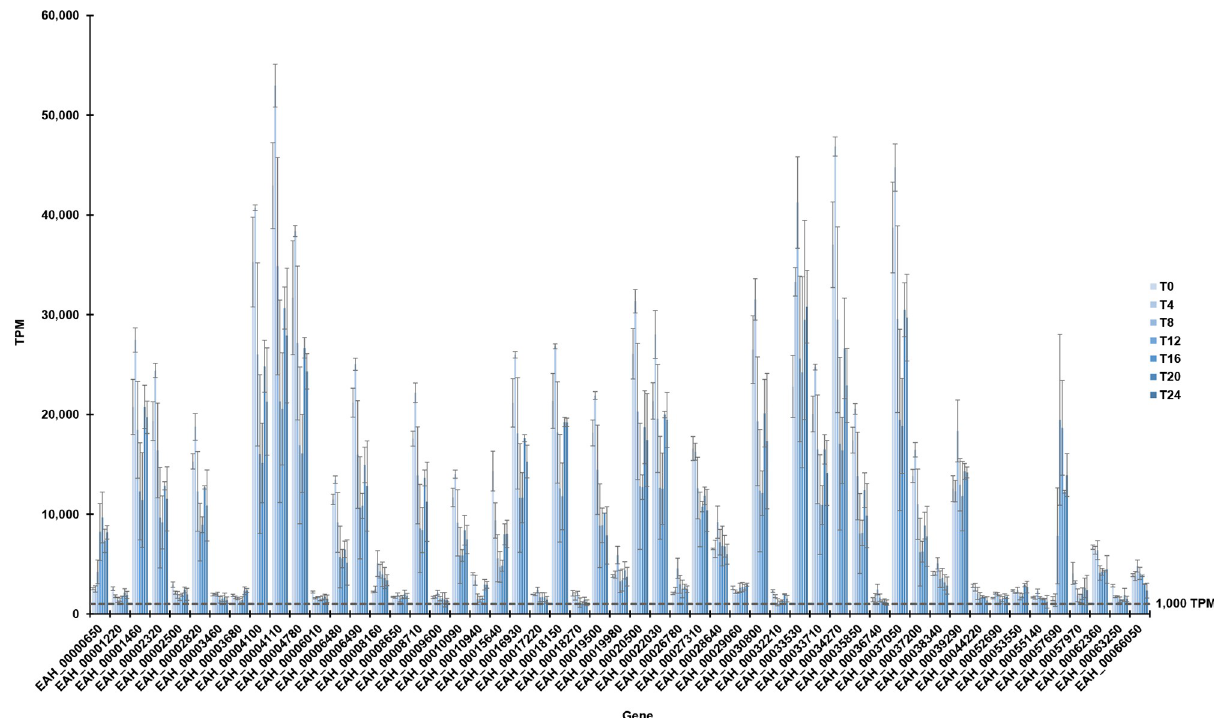
Fig 3. Dynamic constitutive expression of major transcripts throughout E . acervulina sporulation (T0-T24). Fifty-three genes contributed at least 1000 transcripts per million (0.1%) throughout the 24-hour period. Some ( i . e . EAH_0000120; EAH_00002500) contributed a modest and relatively unchanging proportion of total transcripts, whereas others ( i . e . EAH_00004100 and EAH_00004110) contributed more to the total and underwent greater change through time. (Mean TPM and SD among biological replicates).